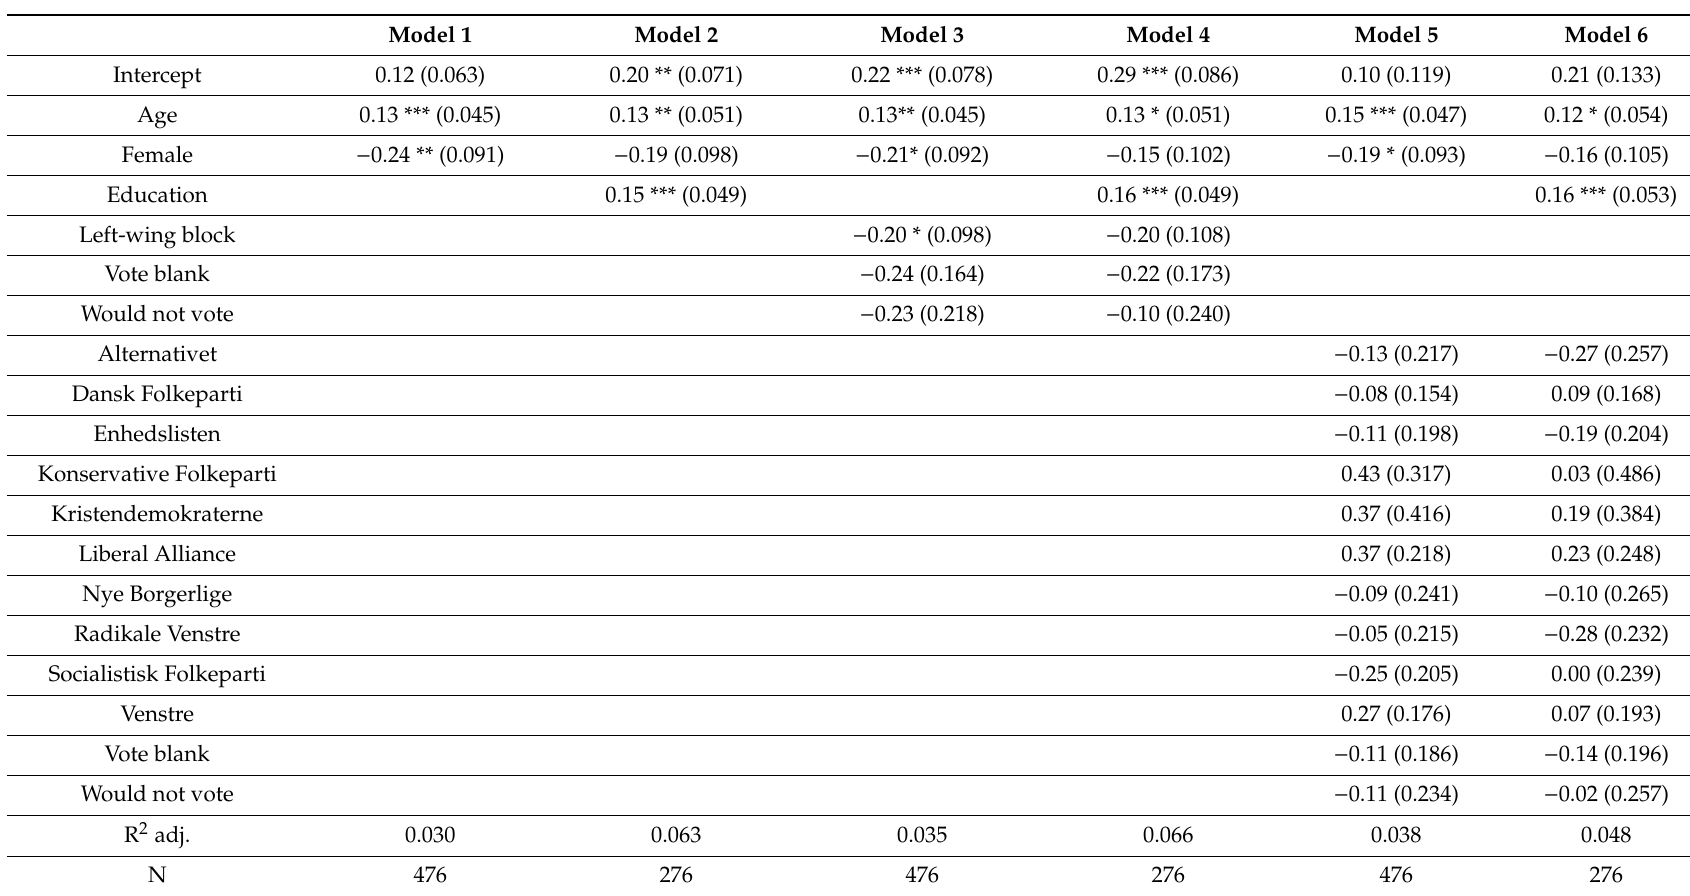
Table 6. Estimates from individual-level regression models. The outcome variable is the stereotype accuracy correlation. Entries are standardized betas. Note that we were unable to obtain education data for all respondents, meaning that the sample size for the models containing that variable was correspondingly reduced. The reference category for gender is ‘male’; the reference category for block vote is ‘right-wing block’; the reference category for party vote is ‘Socialdemokratiet’. Significance levels: * 5%, ** 1%, ***